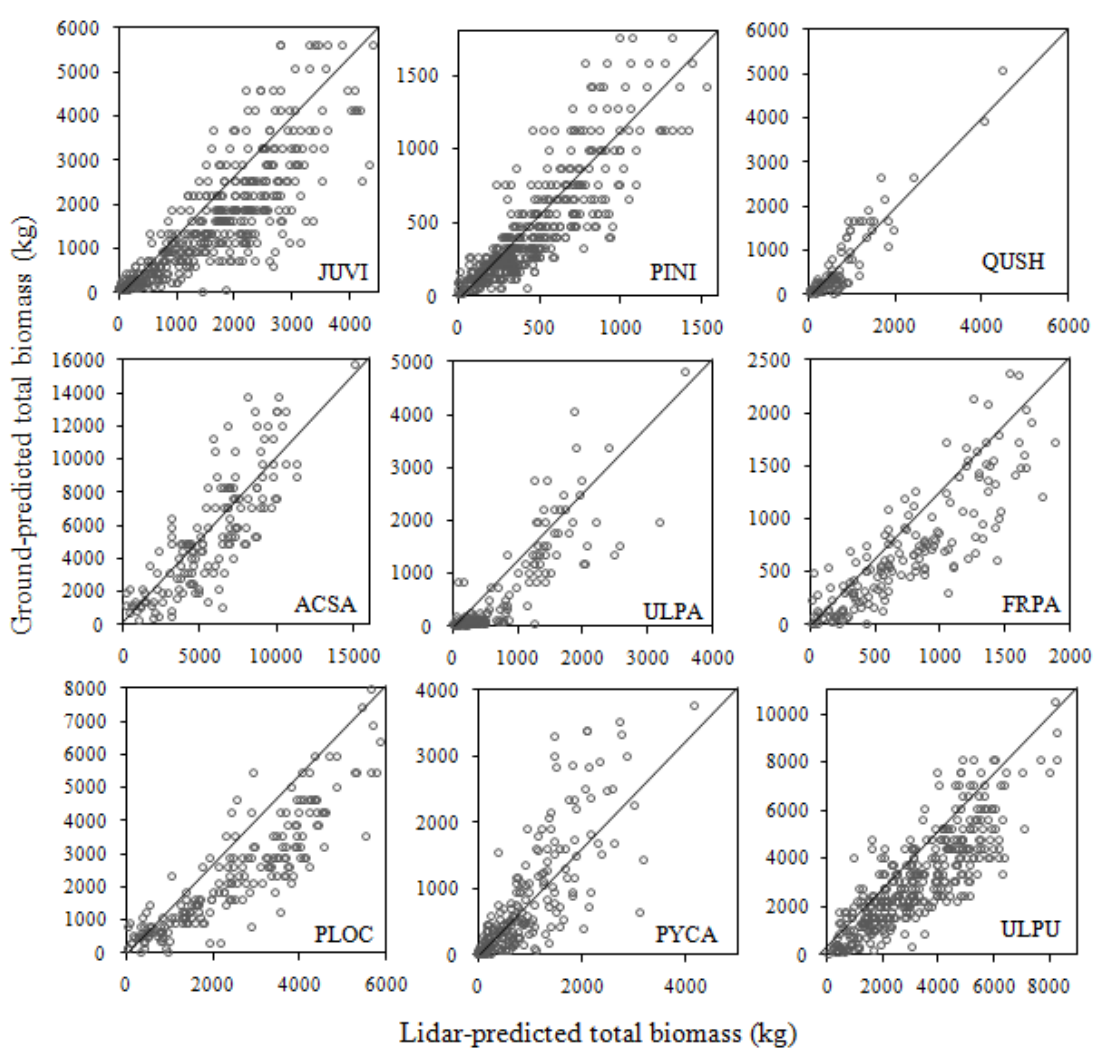
Figure 7. Relationship between total ground-predicted tree biomass and lidar-predicted biomass of major species of the study area. Tree species abbreviations: JUVI = Juniperus virginiana , PINI = Pinus nigra , ULPU = Ulmus pumila , PYCA = Pyrus calleryana , PLOC = Platanus occidentalis , FRPE = Fraxinus pennsylvanica , ULPA =